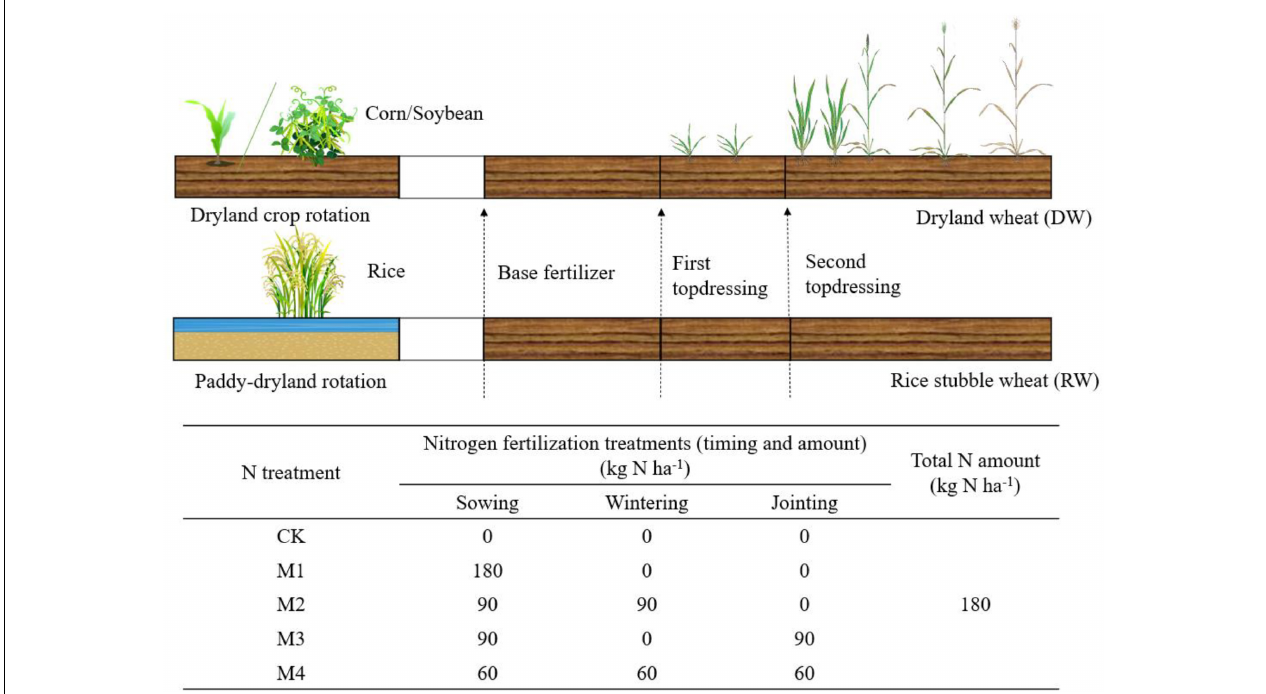
FIGURE 2 | Schematic diagram of crop rotation and nitrogen application